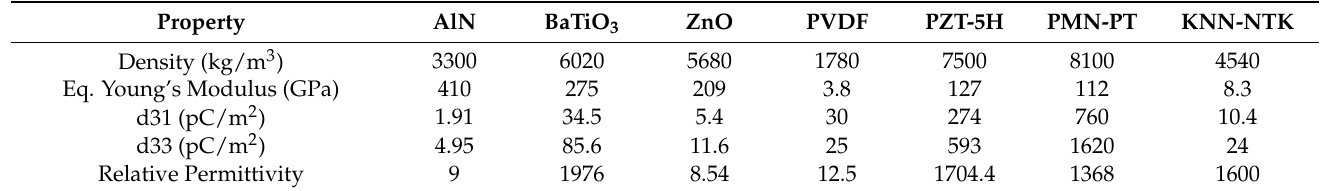
Table 1. The material properties of investigated biocompatible piezoelectric